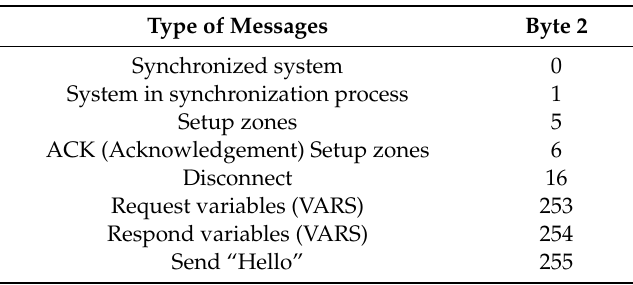
Table 1. Type of messages.